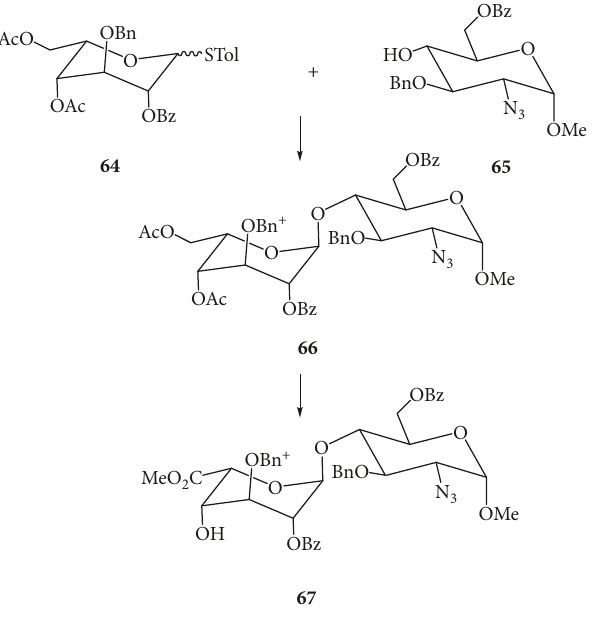
Scheme 20: Synthesis of monosaccharide B fragment from D-glucose.